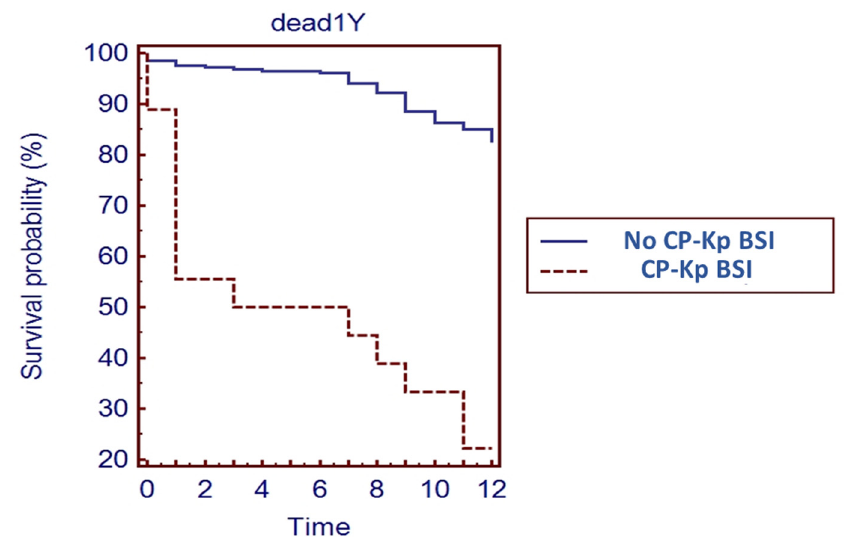
Figure 1. Kaplan–Meier survival curve for SOT recipients with CP- Kp